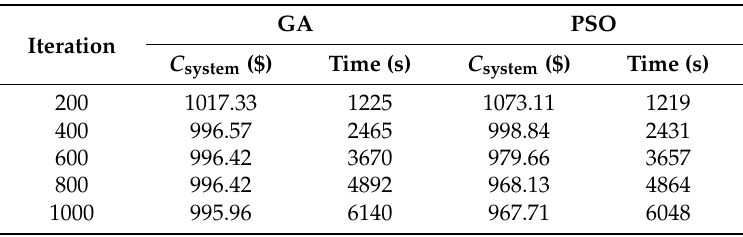
Table 3. The comparison results between a number of iterations and time of use of Genetic Algorithm (GA) and Particle Swarm Optimization